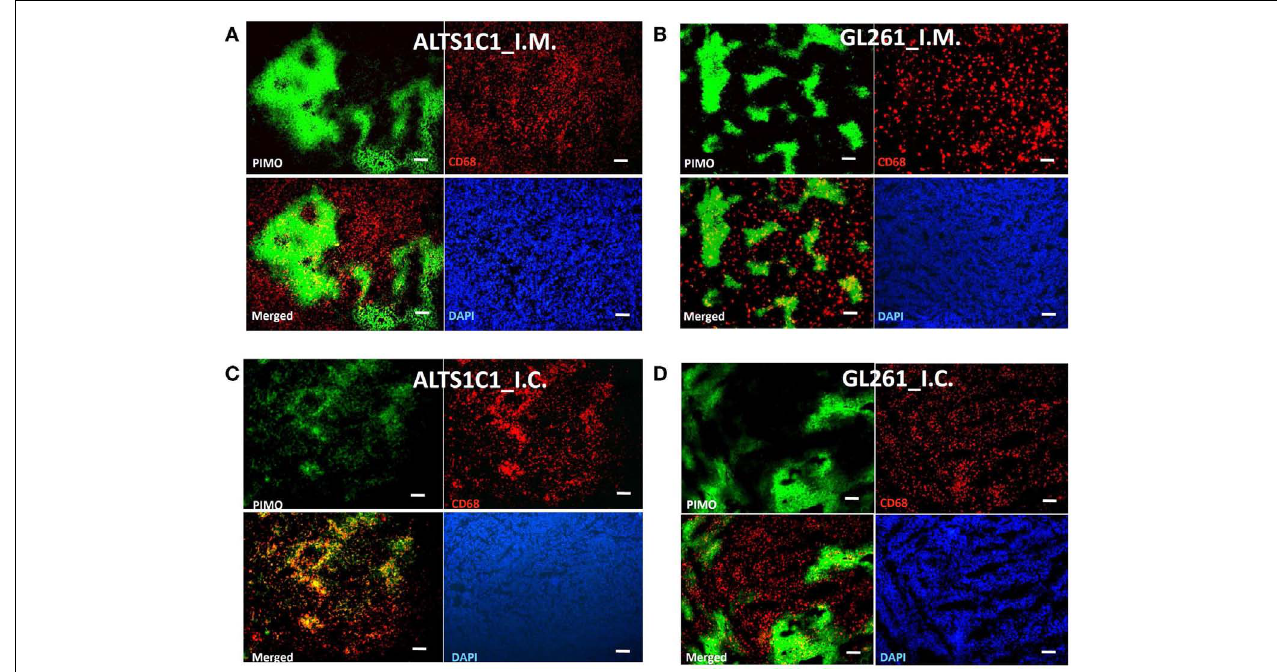
FIGURE 1 |The association of CD68 + TAMs with hypoxia is tumor and tissue dependent. The distribution of CD68 + TAMs and PIMO + hypoxia in ALTS1C1 astrocytoma (A,C) and GL261 glioma (B,D) grown in the thigh (i.m.)